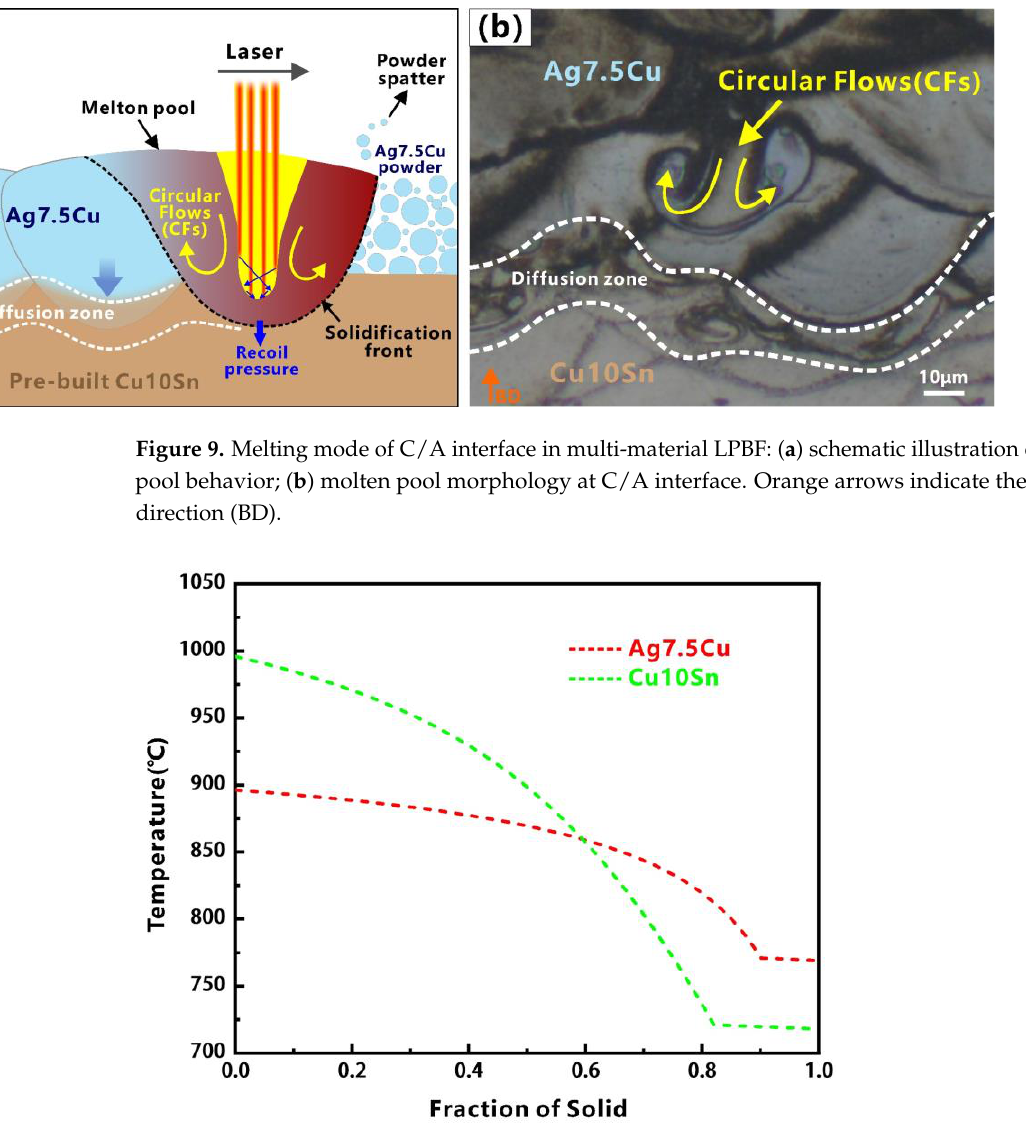
Figure 10. Scheil – Gulliver solidification curves of Ag7.5Cu and Cu10Sn.